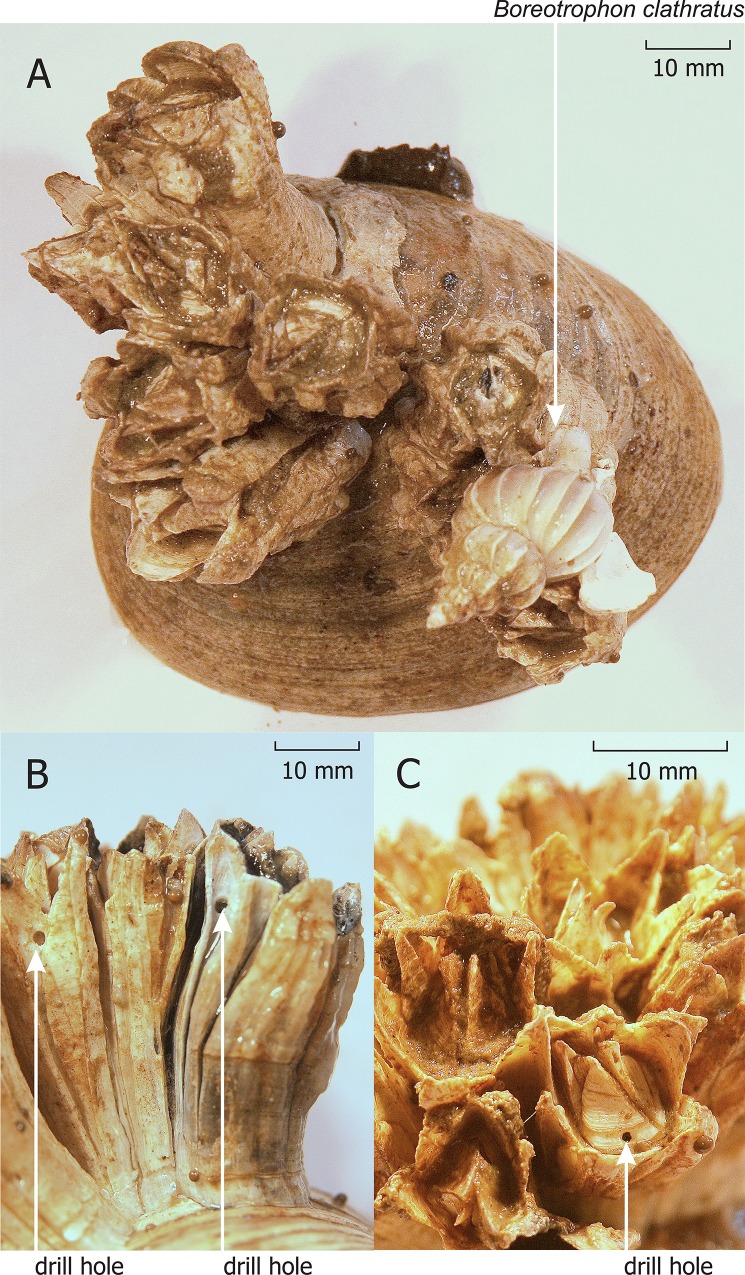

Boreotrophon clathratus and drill holes on Balanus crenatus.(A) Boreotrophon clathratus on Balanus crenatus attached to a Serripes groenlandicus empty shell. Drill holes on a lateral (B) and opercular (C) shell plates of Balanus crenatus empty tests.